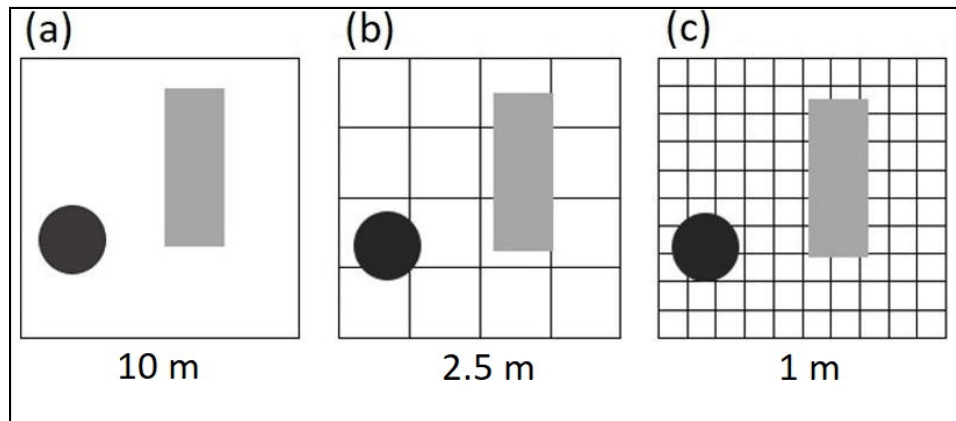
Figure 2. Illustration depicting the effect of spatial resolution on target objects. ( a ) At 10 m pixel resolution it is evident that pixel resolution is much lower (meaning the pixel is larger) than the objects resulting in a mixed class pixel. ( b ) At 2.5 m resolution the objects are closer to actual pixel resolution and are clearly separated meaning this 2.5 m resolution would not result in the mixed pixel problem and pixel redundancy would not be an issue. ( c ) At 1 m resolution objects are larger than pixels resulting in pixel redundancy. Illustration is based on Figure 1 in Blaschke [51].